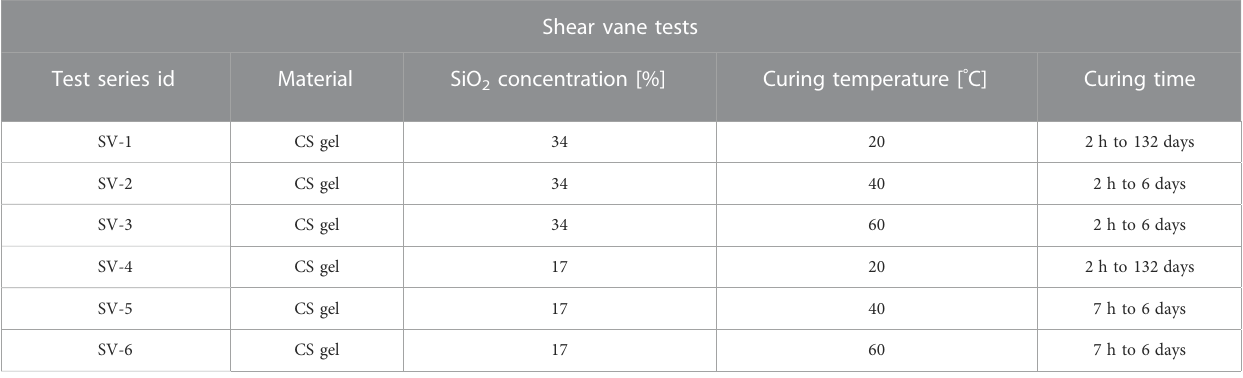
TABLE 2 Summary of shear vane (SV) tests for undrained shear strength determination. Each test series includes specimens from the same grout batch, tested at different times after grout mixing (curing time). Shear vane tests